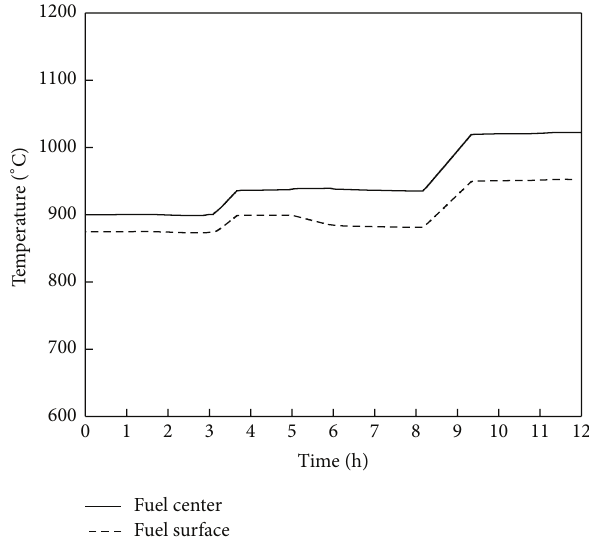
Figure 16: Calculated maximum fuel temperature during the test.